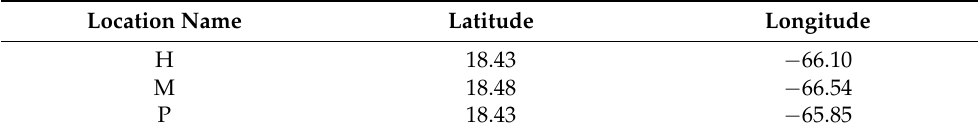
Table 8. The geographical position of